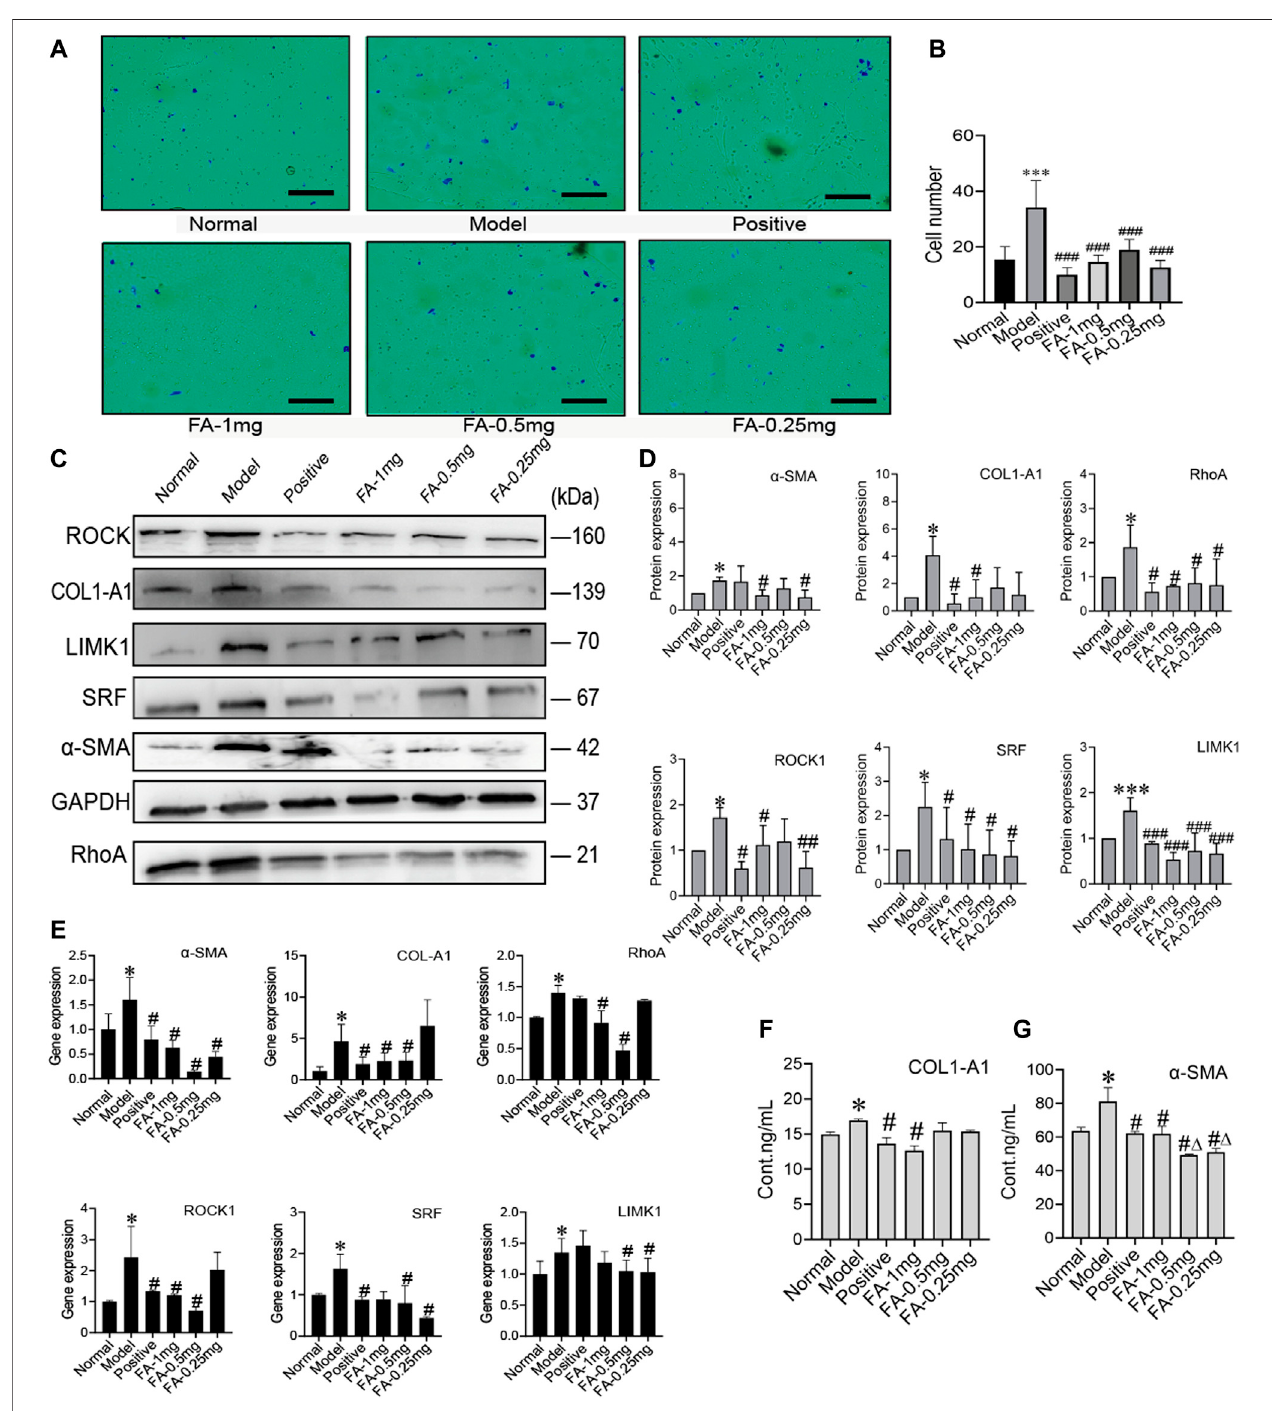
FIGURE 4 | FA promotes BMSC-mediated inhibition of the activation of HSCs. (A) Migration of HSCs (original magni fi cation, ×10; scale bars, 100 μ m). (B) The number of migrating HSCs. ( n = 3 independent experiments, Two-way ANOVA; *** p < 0.001 versus the normal group; ### p < 0.001, versus the model group); (C , D) Westernblotbandsandcumulativedensitometricanalysesofeachgroup(normal,model,positive,FA-1 mg,FA-0.5 mg,FA-0.25 mg).( n =3independentexperiments, Two-way ANOVA; * p < 0.05, *** p < 0.001, versus the normal group; # p < 0.05, ### p < 0.001, versus the model group); (E) qRT-PCR analysis for α -SMA, COL1- A1,ROCK1,RhoA,SRF,andLIMK1inHSCs.( n =3independentexperiments,Two-wayANOVA;* p < 0.05versusthenormalgroup;# p < 0.05versusthemodelgroup); (F , G) The protein content of α -SMA and COL1-A1 in extracellular medium. n = 3 independent experiments, Two-way ANOVA; * p < 0.05 versus the normal group; # p < 0.05 versus the model group; Δ p < 0.05 versus the 1 mg FA